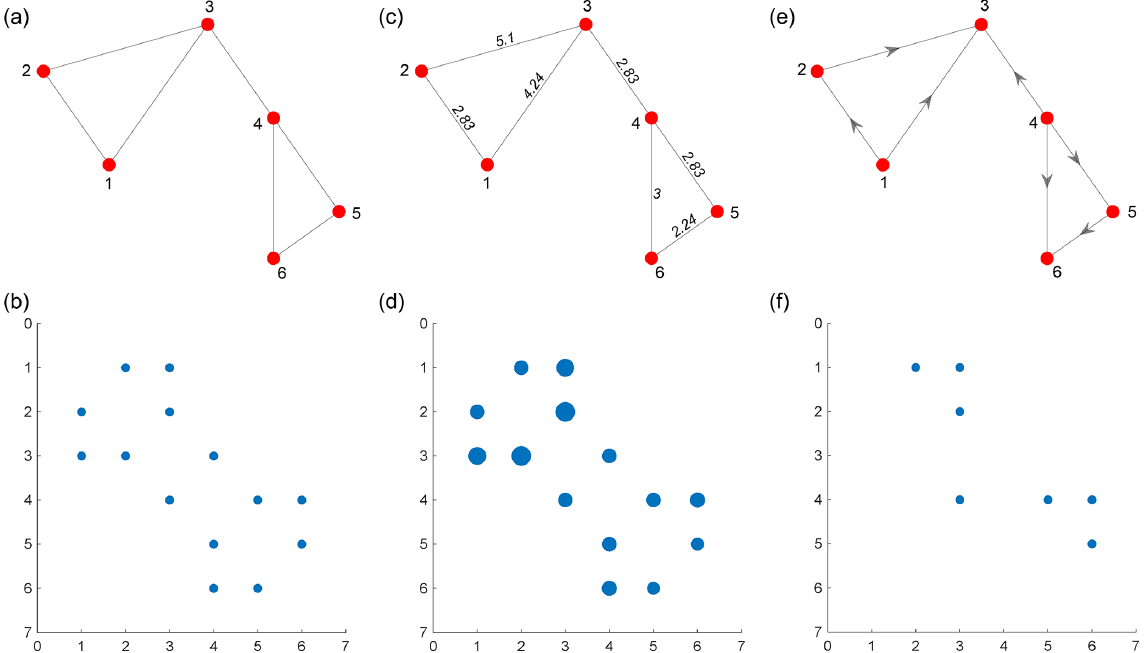
Figure 2. (a) An unweighted planar graph with six nodes and seven edges, (b) adjacency matrix of unweighted graph, (c) a weighted planar graph with edge weights proportional to Euclidean distances between connecting nodes, (d) weighted sparse adjacency matrix for weighted planar graph, (e) a directed, unweighted graph, and (f) adjacency matrix of directed graph.